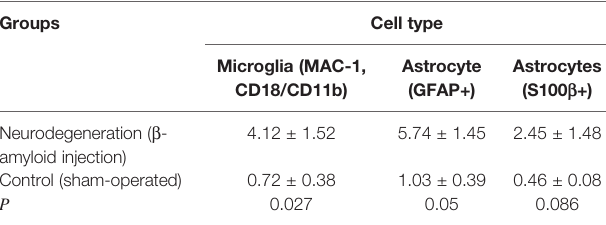
TABLE 1 | The number of CD157+ microglia and astrocytes (%) in olfactory bulbs in control animals and with neurodegeneration.